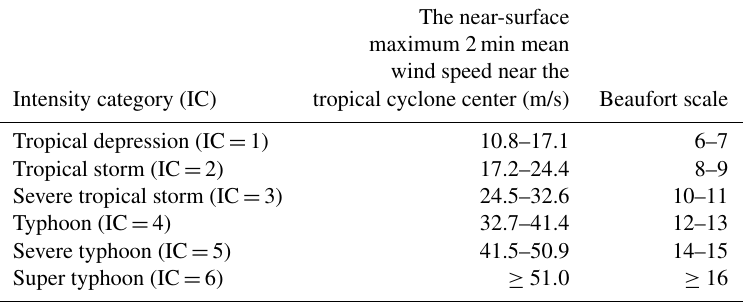
Table 1. The intensity category of tropical